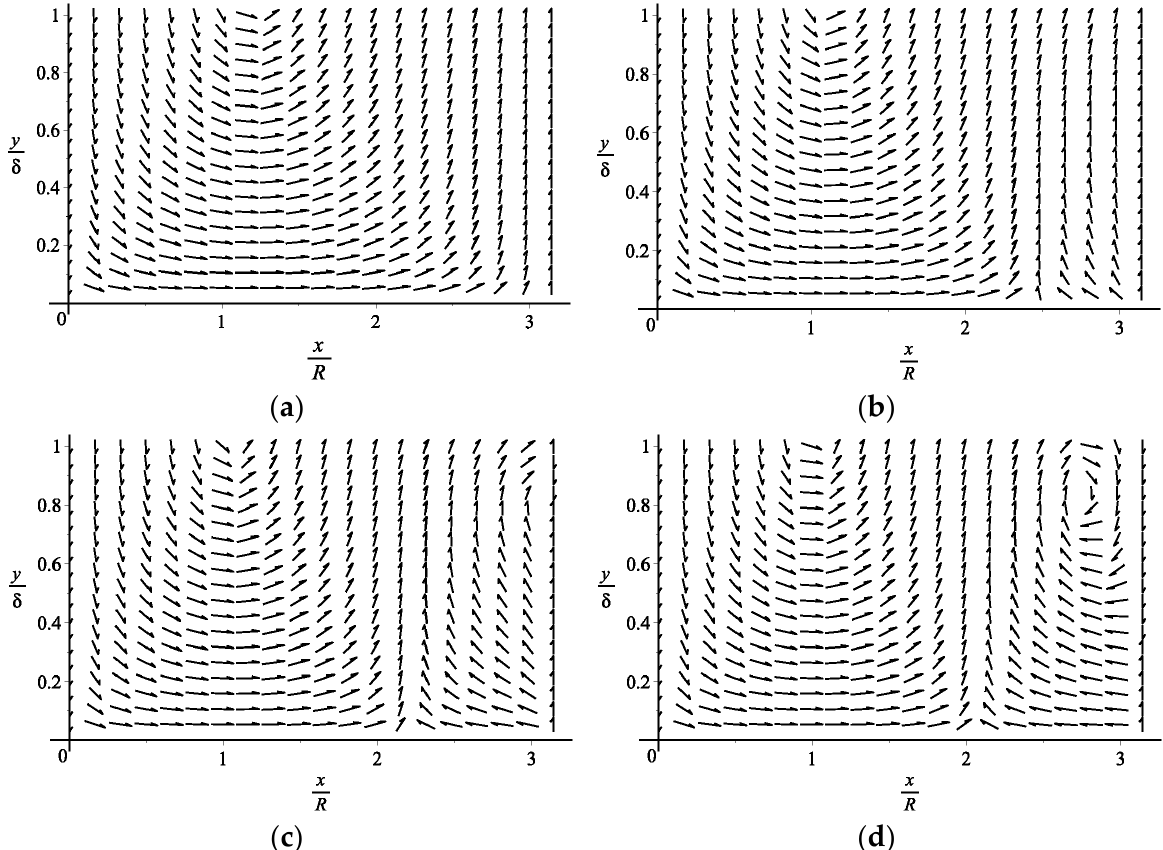
Figure 3. Schematic diagram of the vortex formation by detouring flow(flow-field diagrams when t → ∞ ): ( a ) the flow field diagram when U ∞ = 10 ms − 1 ; ( b ) the flow field diagram when U ∞ = 15 ms − 1 ; ( c ) the flow field diagram when U ∞ = 20 ms − 1 ; ( d ) the flow field diagram when U ∞ = 25 ms − 1